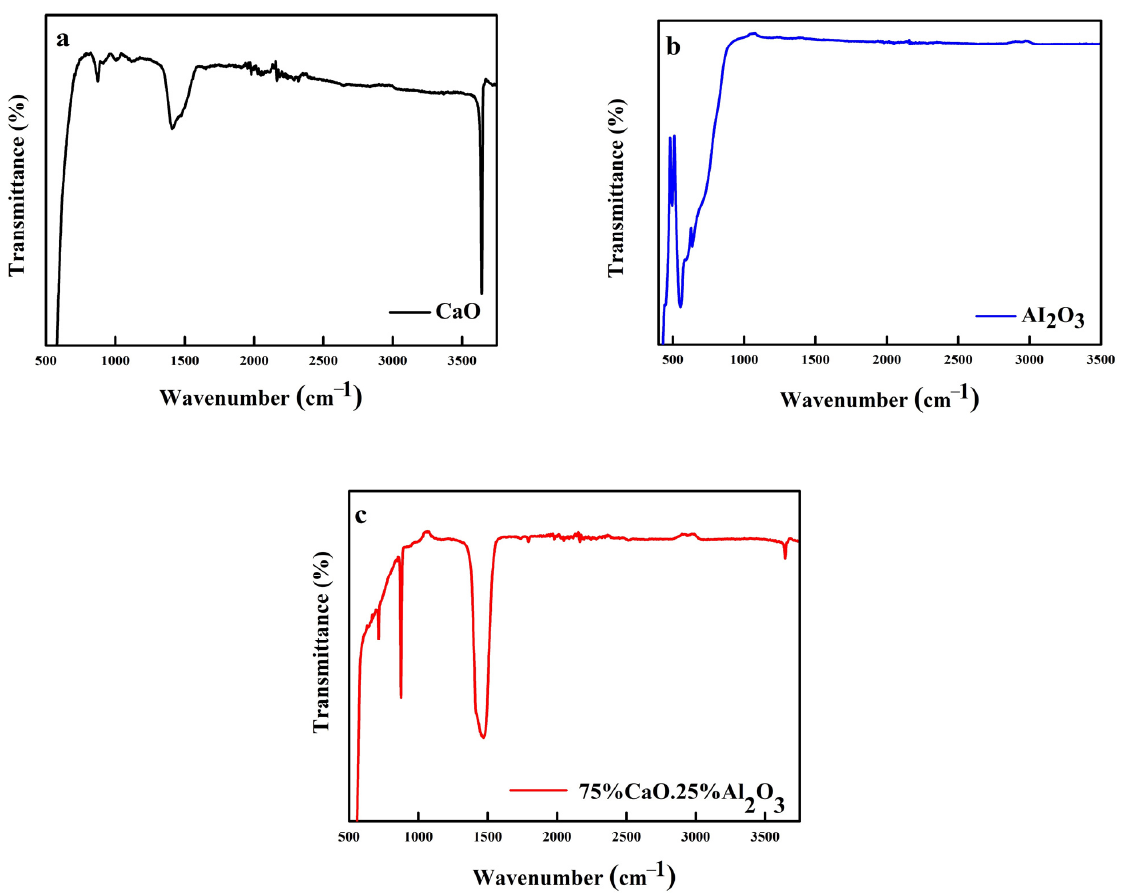
Figure 1. FTIR curves for the ( a ) CaO, ( b ) Al 2 O 3 and ( c ) synthesised CaO/Al 2 O 3 catalyst . Table 1. Composition of compounds within the catalyst.